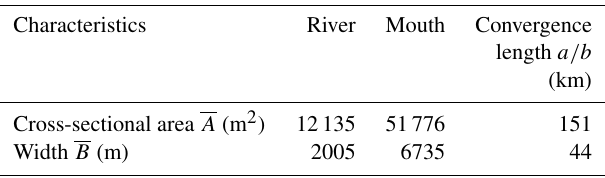
Table 3. Characteristics of geometric parameters in the Yangtze River